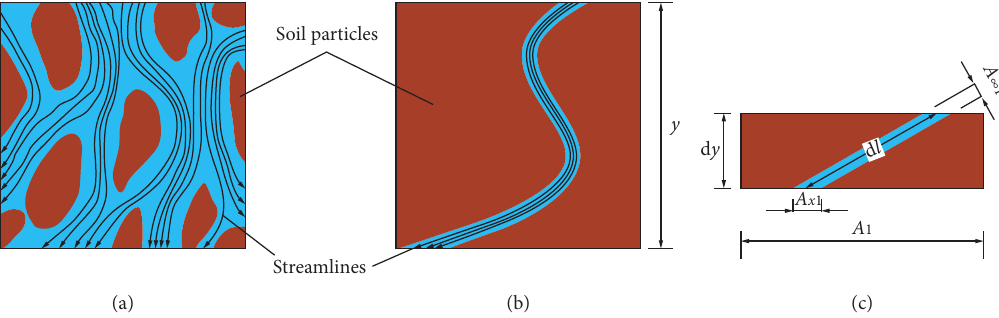
Figure 1: Profile of seepage section. (a) Actual seepage. (b) Hypothetical seepage. (c) Microelement